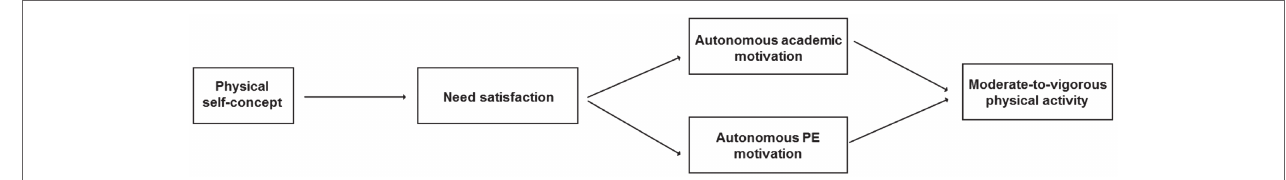
FIGURE 1 | Hypothesized